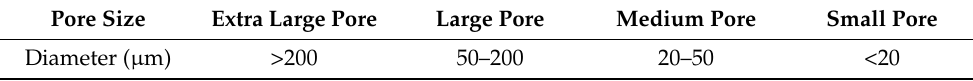
Table 5. Pore types in